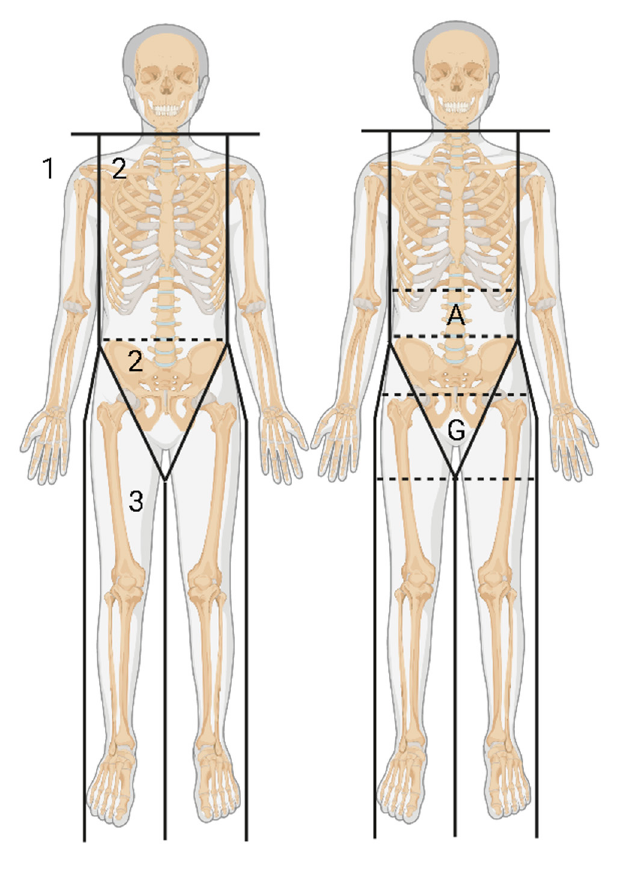
Figure 3. Fat distribution regions measured by dual-energy x-ray absorptiometry. 1. arm fat region; 2. trunk fat region; 3. leg fat region; A. android region; G. gynoid region. Created with Bioren- der.com.